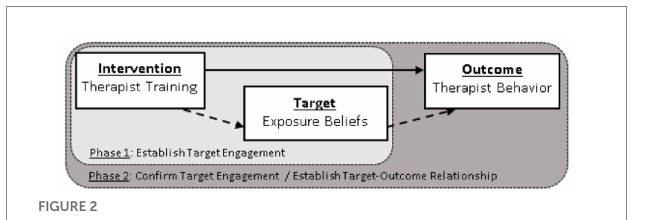
FIGURE 2 Experimental therapeutics